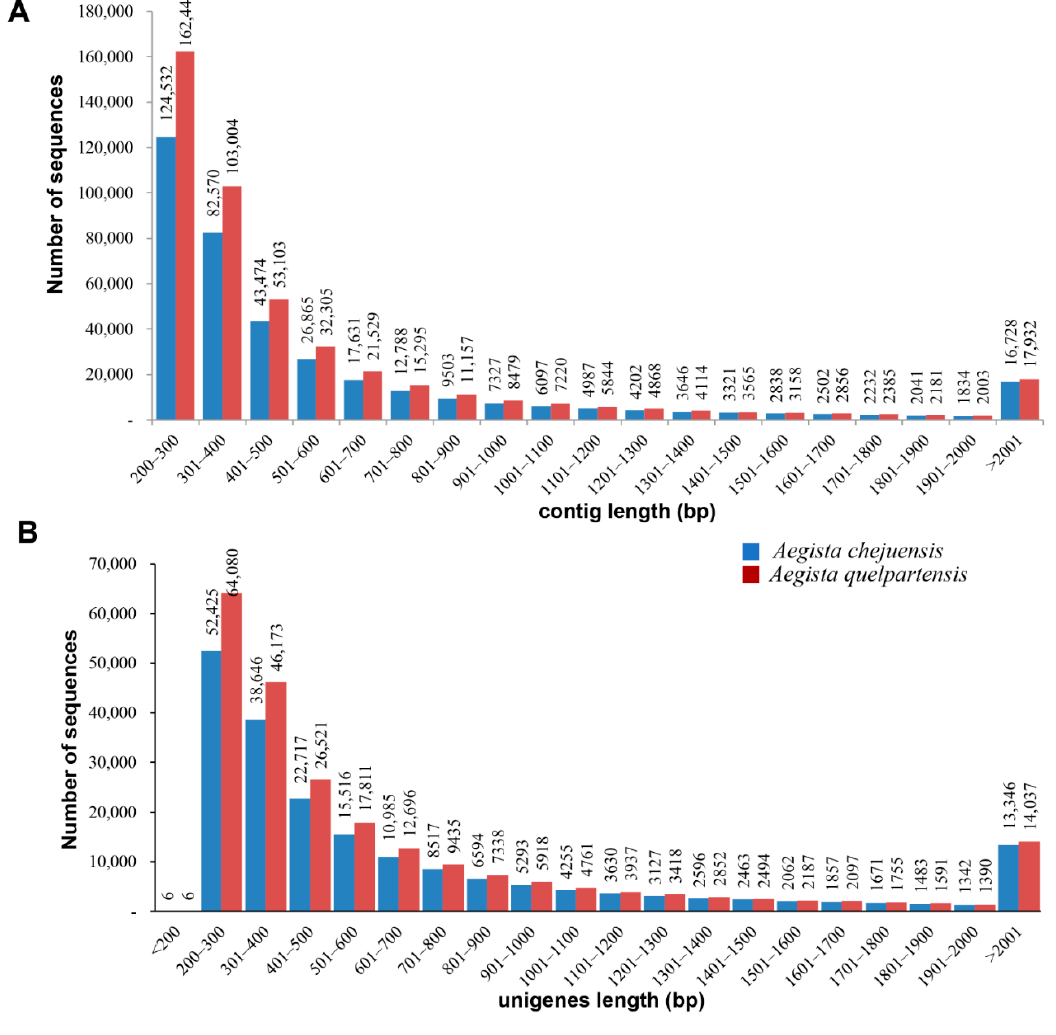
Figure 2. Size distribution of contigs ( A ) and unigenes ( B ) after assembly and clustering of the clean reads obtained from transcriptome sequencing of A. chejuensis and A. quelpartensis .